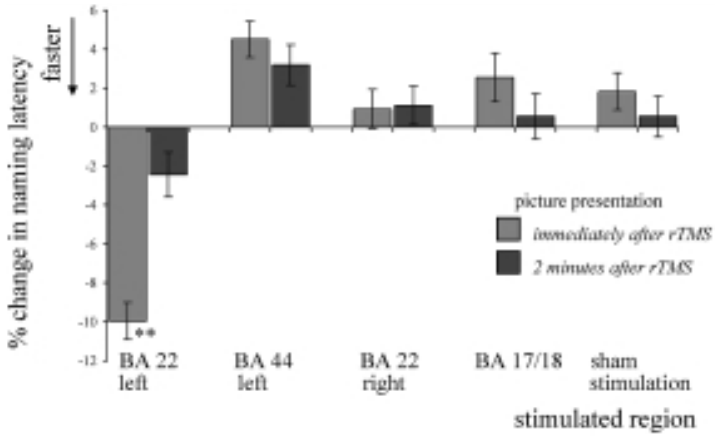
Fig.4. Results ofhigh-frequency rTMSto different targeted brain regions onpicture naming latency. Latency isdepicted aspercent change relative to baseline (i.e., non-TMS) naming latency [23,38]. Only high-frequency rTMS over Wernicke’s area (BA 22 left) preceding picture presentation showed a significant effect. Broca’s area stimulation (BA44), visual cortex (BA 17/18) and right hemispheric homologue to Wernicke’s area (BA 22 right) had no impact on naming